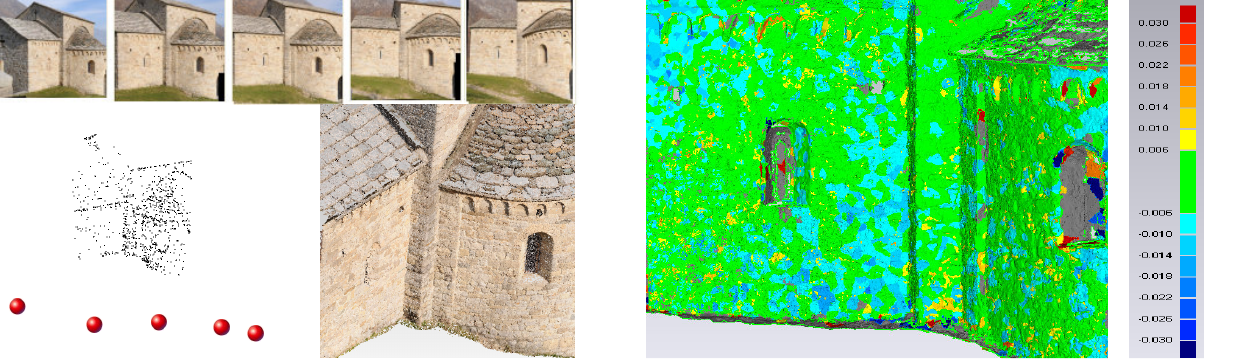
Fig. 8. Comparison between the point cloud extracted from the projections and laser scanner data: the discrepancy is 7 mm. The colour bar ranges from -0.03 to 0.03